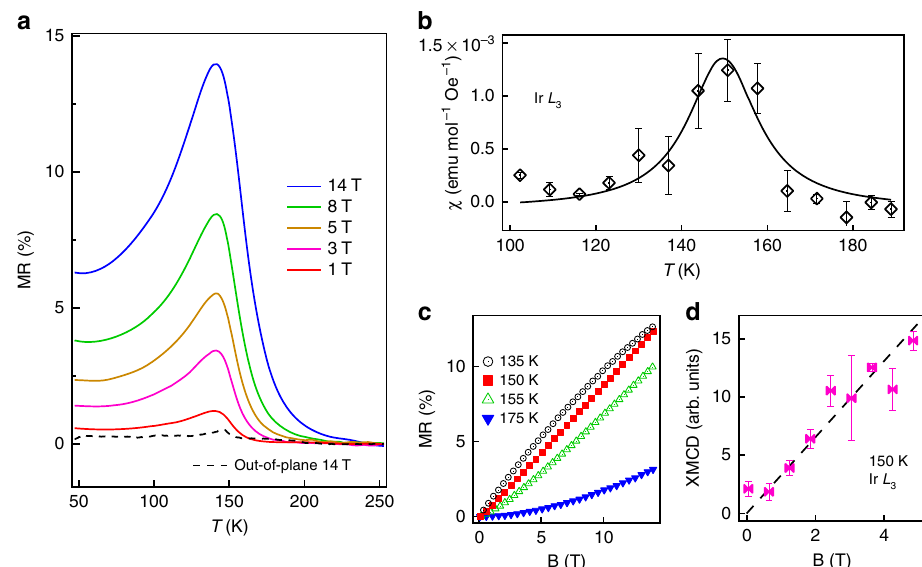
Fig. 2 MR and XMCD measurements. ( a ) T -dependent MR under various in-plane (solid line) magnetic fi elds and a 14 T out-of-plane (dashed line) magnetic fi eld. ( b ) In-plane uniform susceptibility χ extracted from the in-plane fi eld-induced XMCD difference (Supplementary Fig. 3). The solid line is a guide to the eye. In-plane magnetic fi eld dependences of MR ( c ) at various temperatures and XMCD ( d ) at 150 K. The error bars come from the statistical averaging every 0.5